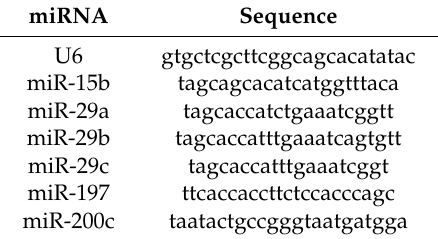
Table 3. Sequences of miRNAs.